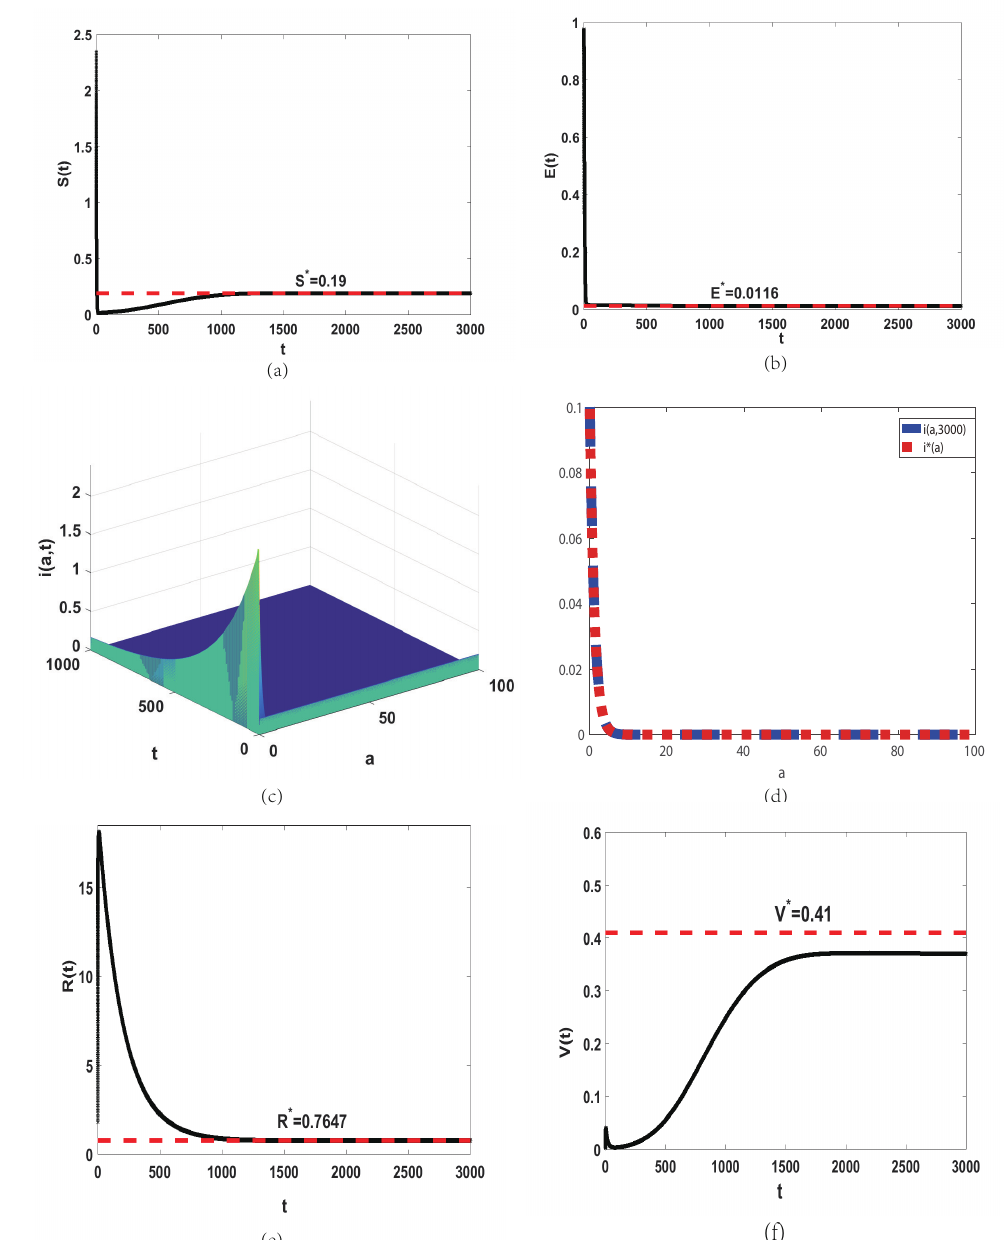
Figure 1. The red dashed lines display the estimate of the endemic steady state E 2 ( 0.19, 0.41, 0.0116, 0.1 e − 0.82 a , 0.7647 ) of model (3a–e)–(5), while other color lines show so- lutions with initial conditions ( 2.5,0.0002,0.2,0.2,0.3 ) and parameters A = 0.006, µ = 20 φ = 1 , δ = 0.125, γ = 0.8, ρ = 0.022, ω = 0.4, σ = 0.15 from the direct simulation. The 100 values of S ( t ) , E ( t ) , R ( t ) , V ( t ) with respect to t are shown in ( a , b , e , f ), respectively. i ( a , t ) with respect of a and t is shown in ( c ). The value of i ( a , t ) with respect to a at t = 3000 is shown in ( d